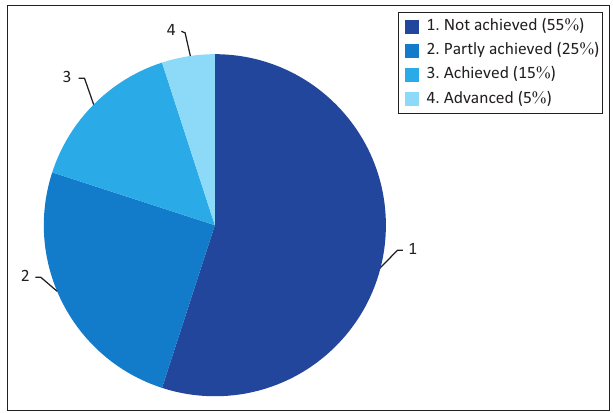
FIGURE 1-A1: Distribution of learners across mathematics performance levels.